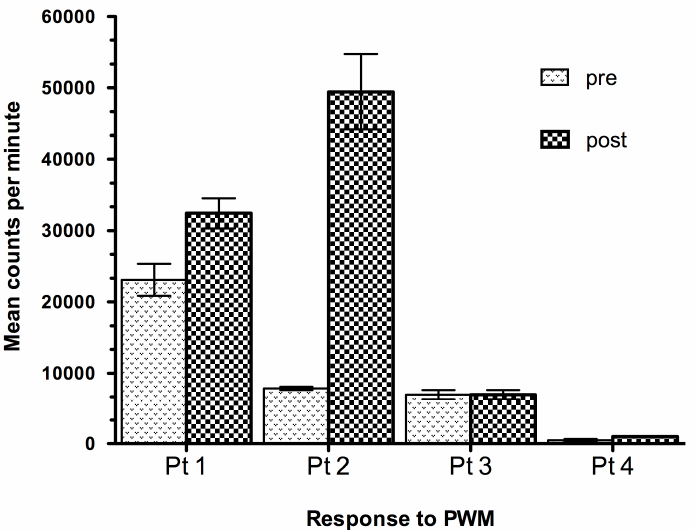
Figure 3. Response to Mitogen after Oral Probiotic Lp299v Treatment in Congenital HIV Infection. Data show pre-treatment compared to post-treatment proliferative response to pokeweed mitogen (PWM) in vitro at 3 months for 4 representative patients who were given oral Lp299v supplements. Mononuclear cells were cultured in triplicate and plated at 50,000 lymphocytes per well and pulse labeled with radio labeled tritiated thymidine. Data are shown as maximum mean response to a range of doses after 4 days total